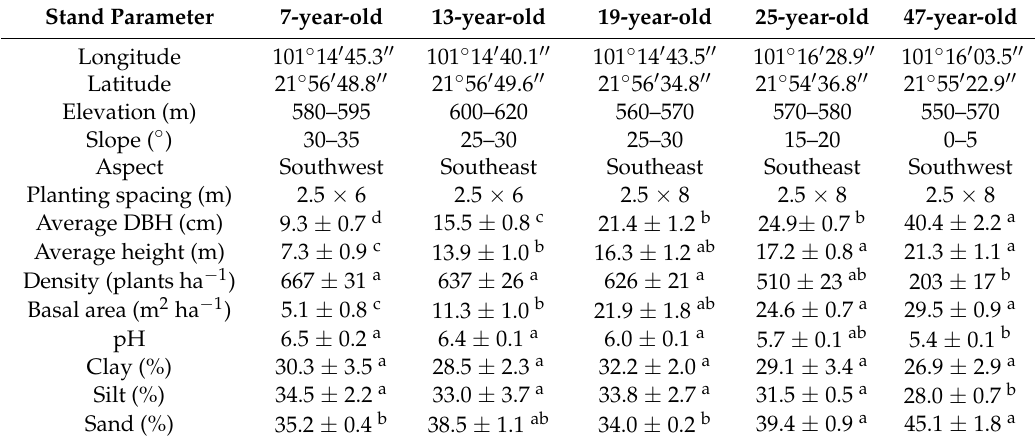
Table 1. Stand and soil characteristics of the 7-, 13-, 19-, 25- and 47-year-old rubber plantations at Xishuangbanna, Yunnan Province,